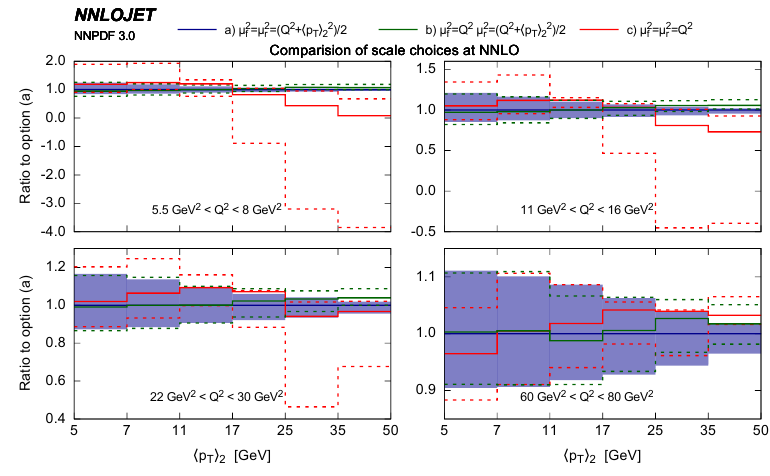
Figure 7 . Di-jet production cross sections for di(cid:11)erent scale